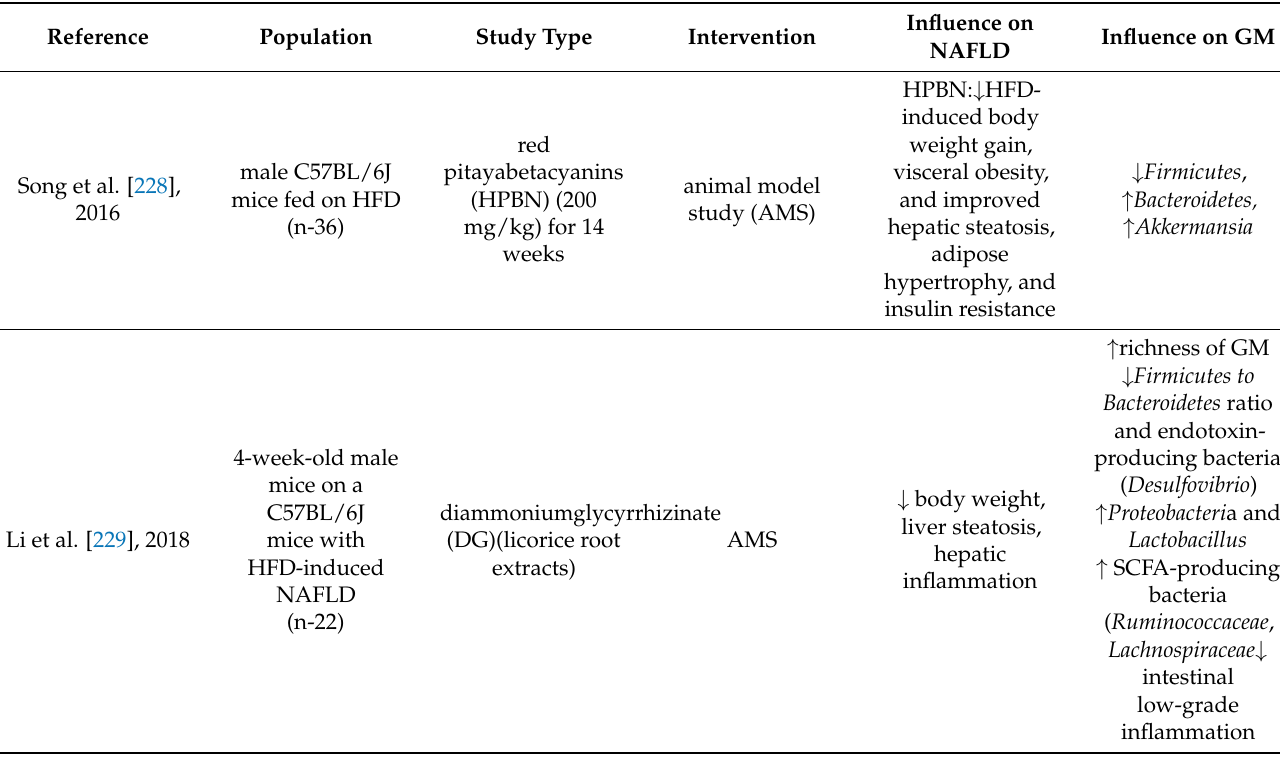
Table 3. Summary of the recent clinical study concerning polyphenols and other bioactive substances on GM and liver- related outcomes in NAFLD/NASH